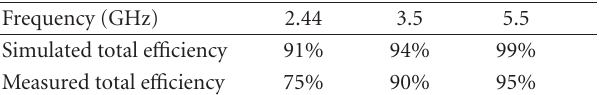
Figure 14: 3D simulated radiation patterns at 3.5GHz when the terminal is used in hand. Table 1: Measured and simulated e ffi ciency of the proposed antenna.